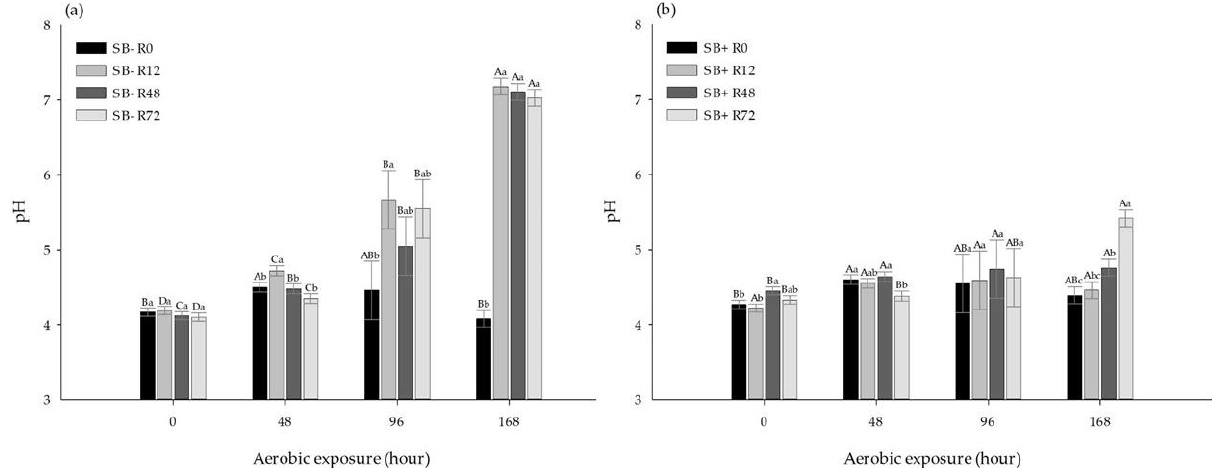
Figure 5. ( a ) The effects of the additive application (SB) × relocation time × aerobic exposure time interaction (A × R × AE) on the pH of sugarcane silage that was stored for 60 days: SB − , without additive; ( b ) the effects of the additive application (SB) × relocation time × aerobic exposure time interaction (A × R × AE) on the pH of sugarcane silage that was stored for 60 days: SB+, with additive (sodium benzoate at 2 g · kg − 1 on a fresh matter basis). Means followed by lowercase letters differ from each other within each aerobic exposure time according to Tukey’s test ( p > 0.05). Means followed by uppercase letters differ between aerobic exposure times according to Tukey’s test ( p > 0.05).